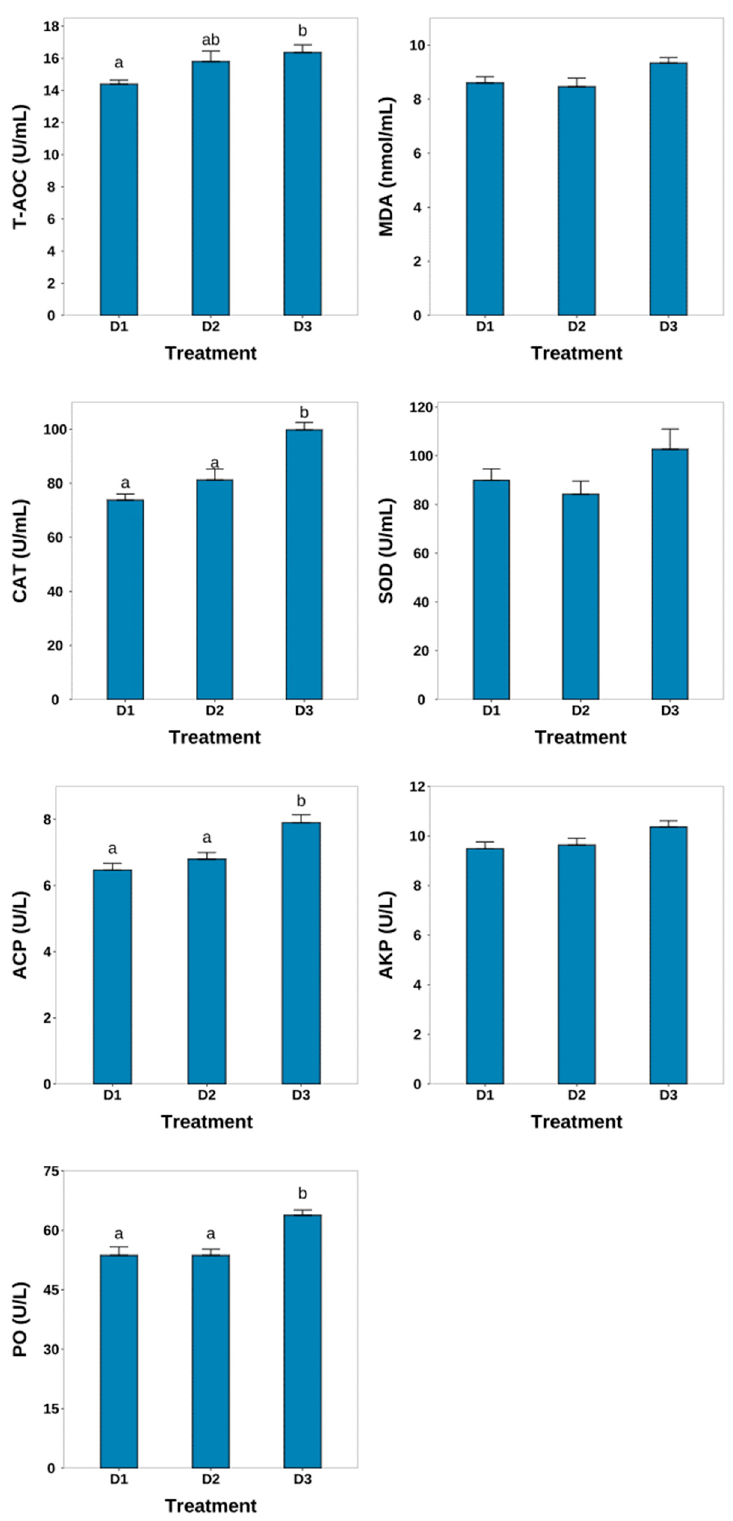
Figure 4. The concentrations of T-AOC and MDA and the activities of CAT, SOD, ACP, AKP, and PO in ovigerous P. clarkii at different shelters after 25 days. Different lowercase letters indicate significant differences ( p < 0.05) among shelter